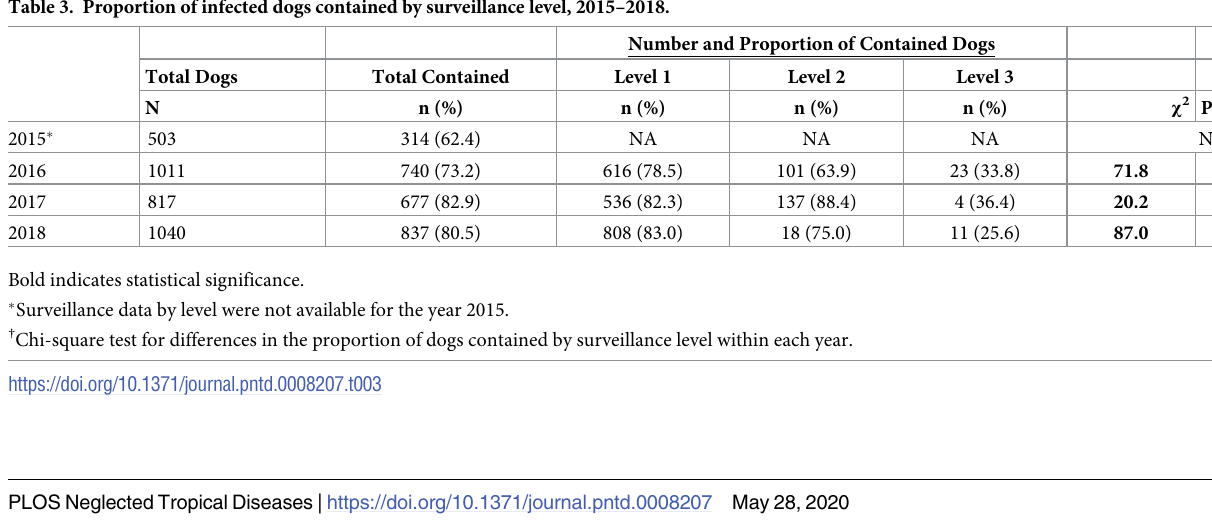
Table 3. Proportion of infected dogs contained by surveillance level, 2015–2018.